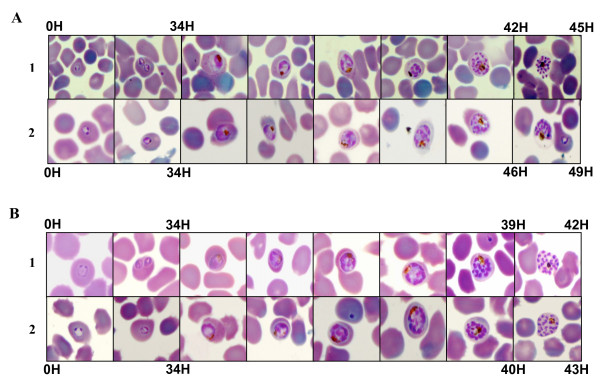
Cell cycle evolution of asexual blood stages of Plasmodium falciparum. A: 3D7 clone. B: W2 clone. 1: 5% O2. 2: 21% O2.